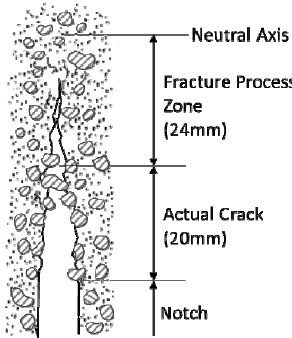
Figure 17. The concept of actual crack depth and neutral axis.